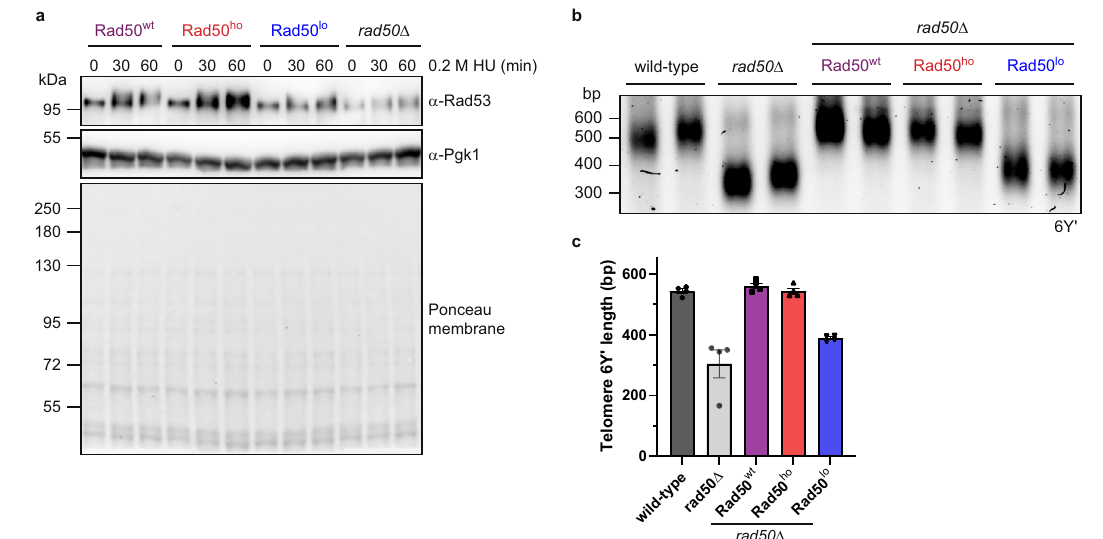
Fig. 6 DNA damage checkpoint activation and telomere maintenance. a Activation of the Rad50 wt/ho/lo -mediated DNA damage checkpoint, monitored by HU-induced Rad53 phosphorylation ( α -Rad53). In contrast to untagged Rad50 wt/ho , the upshift of the phosphorylated Rad53 band is reduced in rad50 4 and Rad50 lo -expressing cells (see also Supplementary Fig. 7b). α -Pgk1 controls equal loading. n = 2. b Representative telomeric PCR analysis for telomere 6Y ′ in two clones per genotype. PCRs were performed with oligonucleotides oBL361 and oBL359 (see also “ Methods ” and Supplementary Fig. 7c). n = 4. c Quanti fi cation of telomeric PCR analysis of telomere 6Y ′ in b . Fragment length was determined by using the 100 bp DNA ladder as size reference. n = 4 for each genotype; mean ± SD. Note that rad50 4 and Rad50 lo -expressing cells have shorter telomeres than cells with Rad50 wt/ho